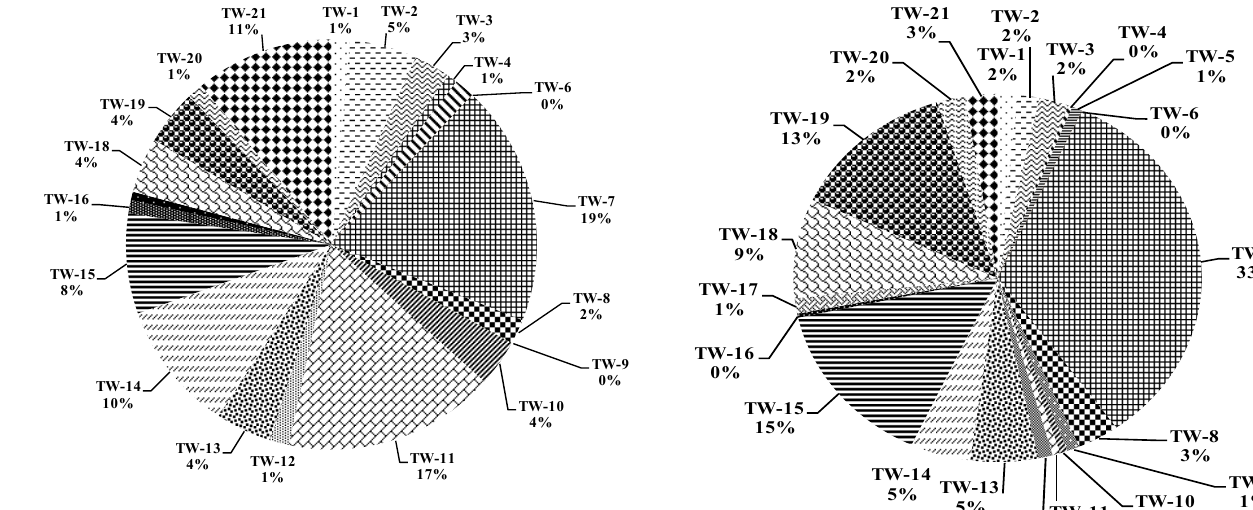
Figure 2. Relative abundance of OCP in di ff erent borewell samples (Pre-monsoon). Figure 3 Relative abundance of OCP in different Ranney well samples (Pre-monsoon)